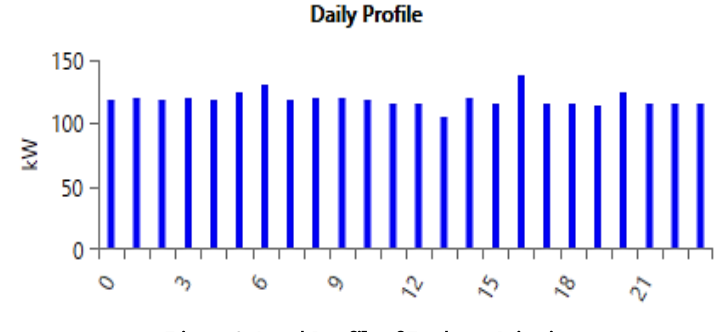
Figure 3. Load Profile of Turkana District